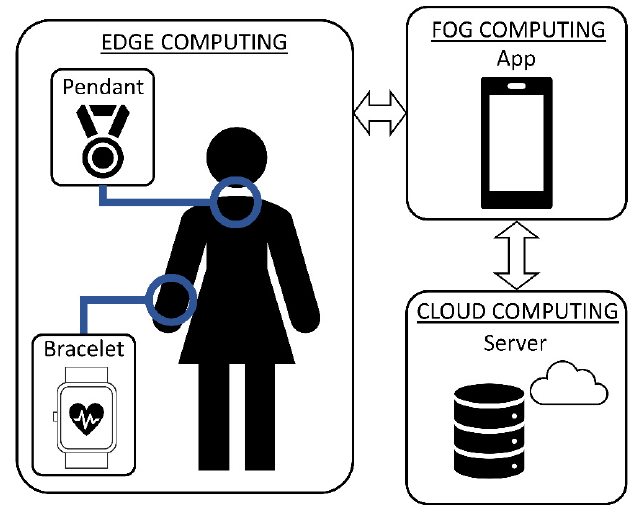
Figure 2. Bindi architecture as an IoT